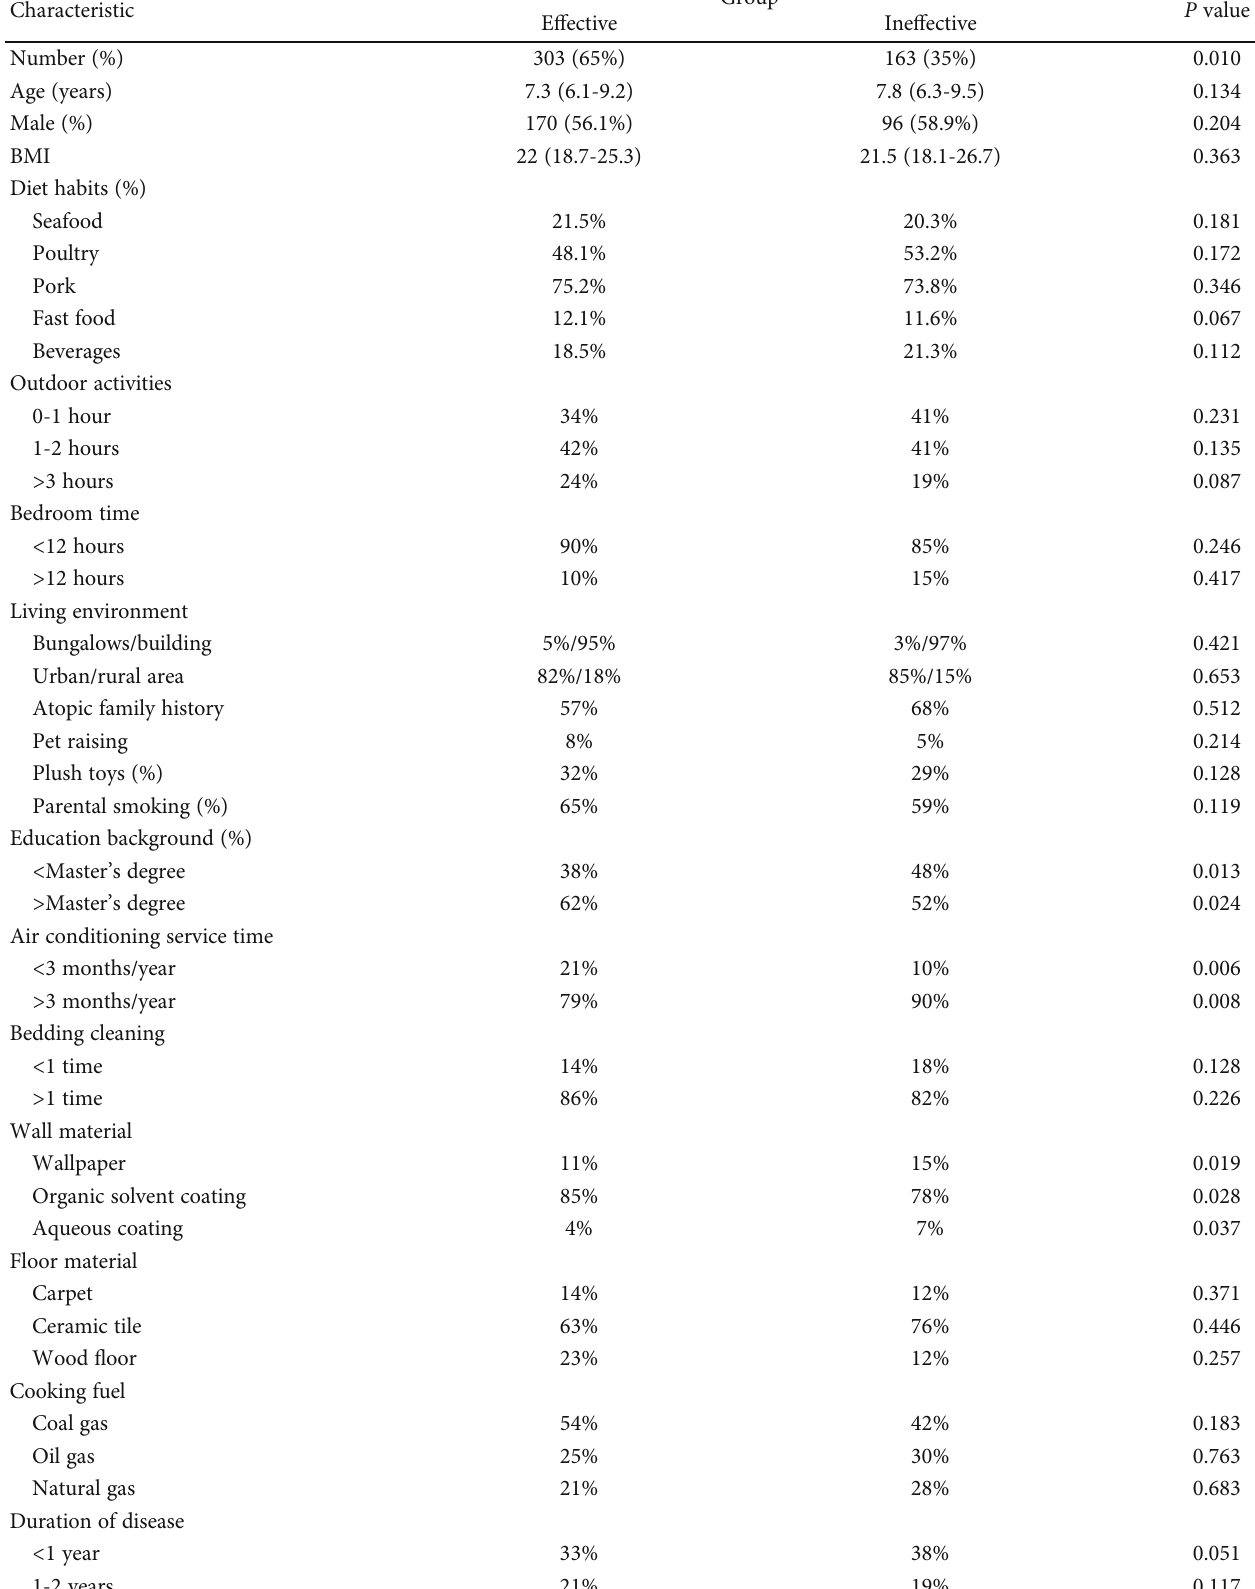
Table 5: Univariate logistic analysis of factors associated with clinical response to